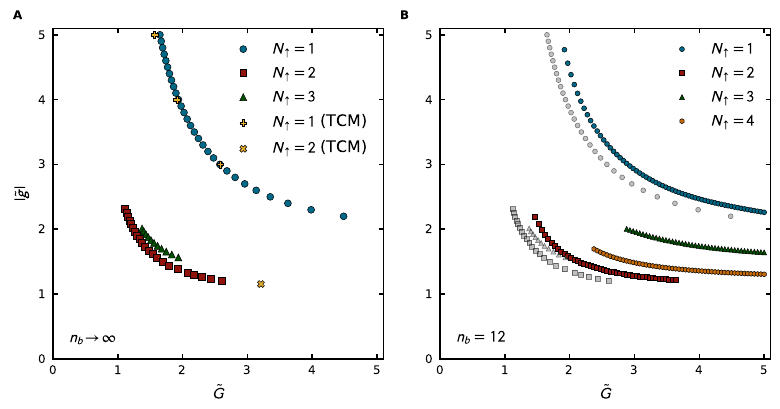
Figure 5: Approaching the many-body limit. Points where the ground-state en- ergies for balanced and imbalanced particle configurations are equal, i.e., where E ( N ↑ + N ↓ ) = E ( N ↑ +( N + 1 ) ↓ ) . The data are shown as a function of the rescaled fermion-fermion interaction strength ˜ g and the rescaled magnetic impurity interac- tion strength ˜ G , see Eq. (6). Results are shown for N ↑ ≤ 4, see the legend. In all cases the upper left (lower right) area corresponds to the S = 1 / 2 ( S = 0) phase. (A) Phase diagrams obtained from ground-state energies extrapolated to the infinite basis limit. Here, we also include benchmark results of the transcorrelated method (TCM) for the N ↑ = 1 and N ↑ = 2. In the former case, we relied on exact diagonaliza- tion. In the latter case, we used FCIQMC with 5 × 10 8 walkers. In both cases, a basis = 12 (colored of 75 plane waves was used. (B) Phase diagrams at finite cutoff n b symbols) compared to the extrapolated results (gray